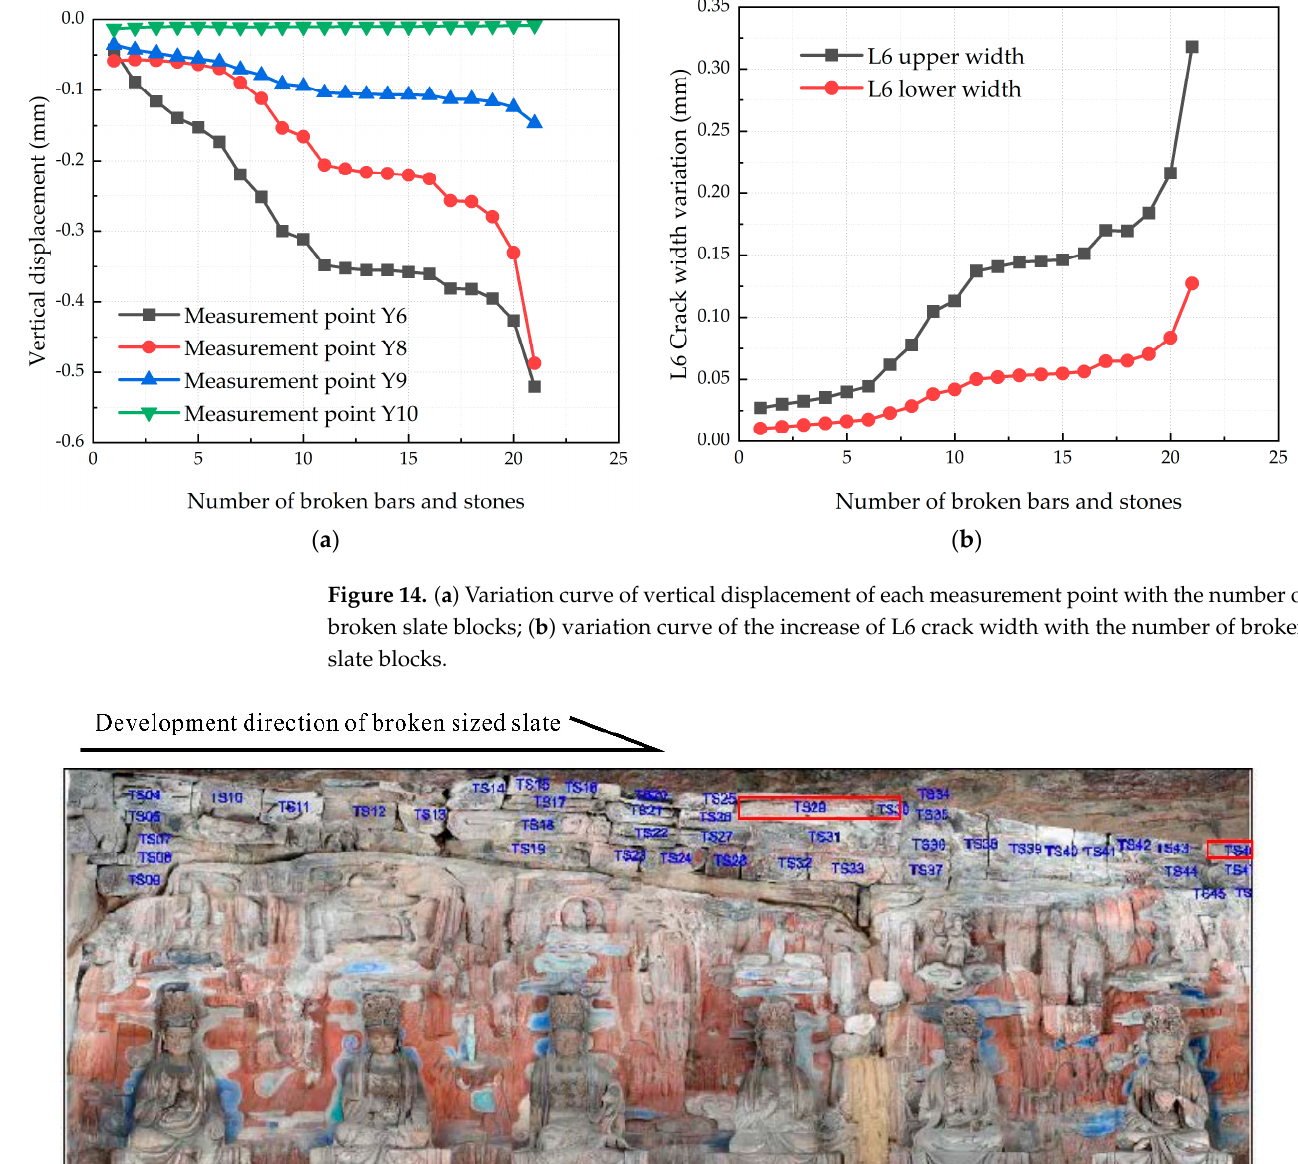
Figure 14 ( a ) Variation curve of vertical displacement of each measurement point with the number of broken slate blocks; ( b ) variation curve of the increase of L6 crack width with the number of broken slate blocks.